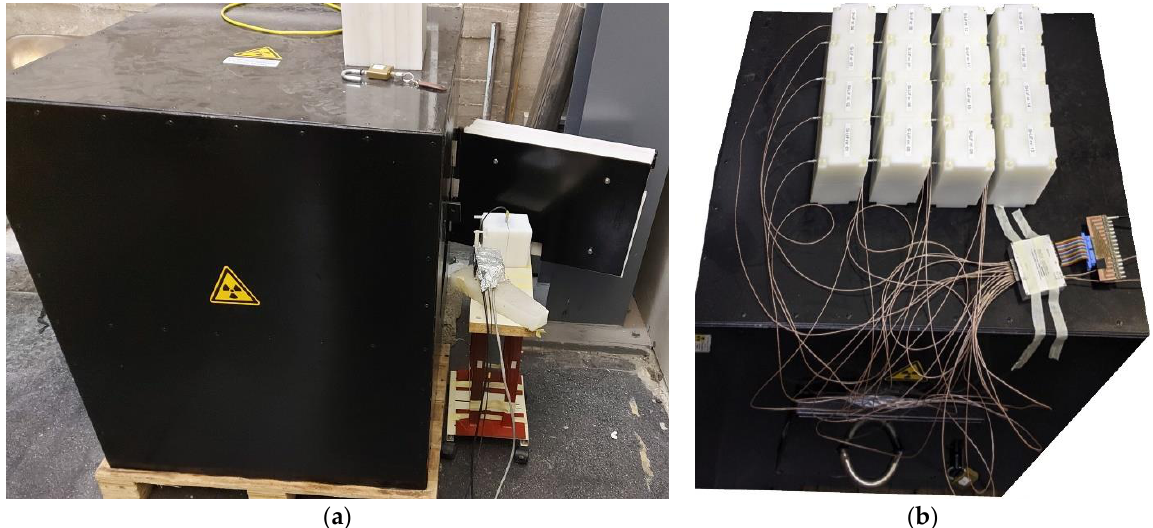
Figure 6. ( a ) The AmBe neutron source box with a SiLiF detector during a measurement in the front position. ( b ) The 4 × 4 array of SiLiF detectors during the measurement in the top position.